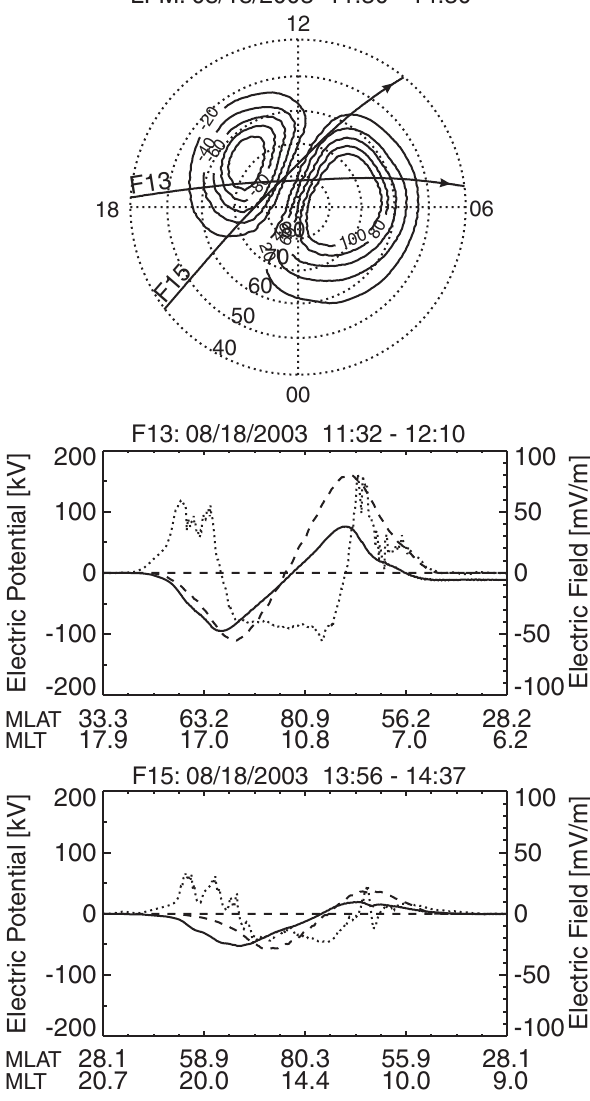
Fig. 13. Comparison of (a) the LFM electric potential distribution with observations by (b) DMSP F13 and (c) DMSP F15 on 18 Au- gust 2003, 11:30–14:30UT. The line plots show the DMSP electric field (dotted line) and electric potential (solid line) and the LFM electric potential interpolated along the satellite